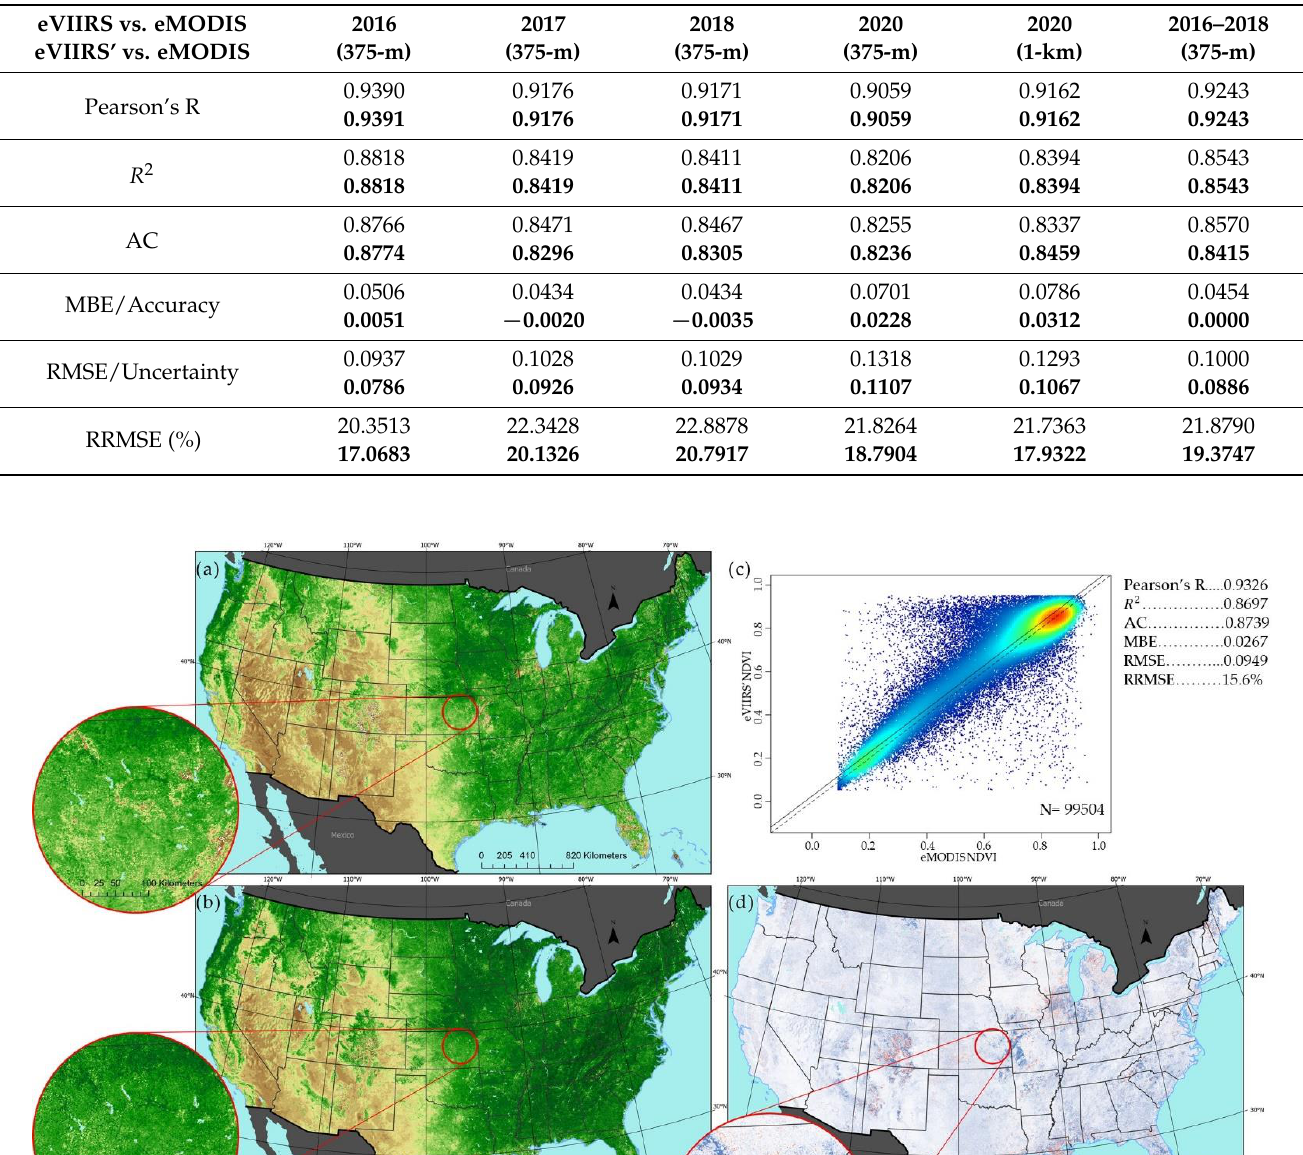
Table 1. Expedited Visible Infrared Imaging Radiometer Suite (eVIIRS) Normalized Difference Vegetation Index (NDVI) comparison to expedited Moderate Resolution Imaging Spectroradiometer (eMODIS) NDVI. In the 2020 column, the results include the four 375-m and 1-km 7-day NDVI composites, starting with composites Julian day of year 196–202 through 217–223. The plain text values represent eVIIRS compared to eMODIS and the bold text values represent transformed eVIIRS (eVIIRS’) compared to eMODIS. Pearson’s R significance test resulted in p -values <2.2 × 10 − 16 for all of the years processed.